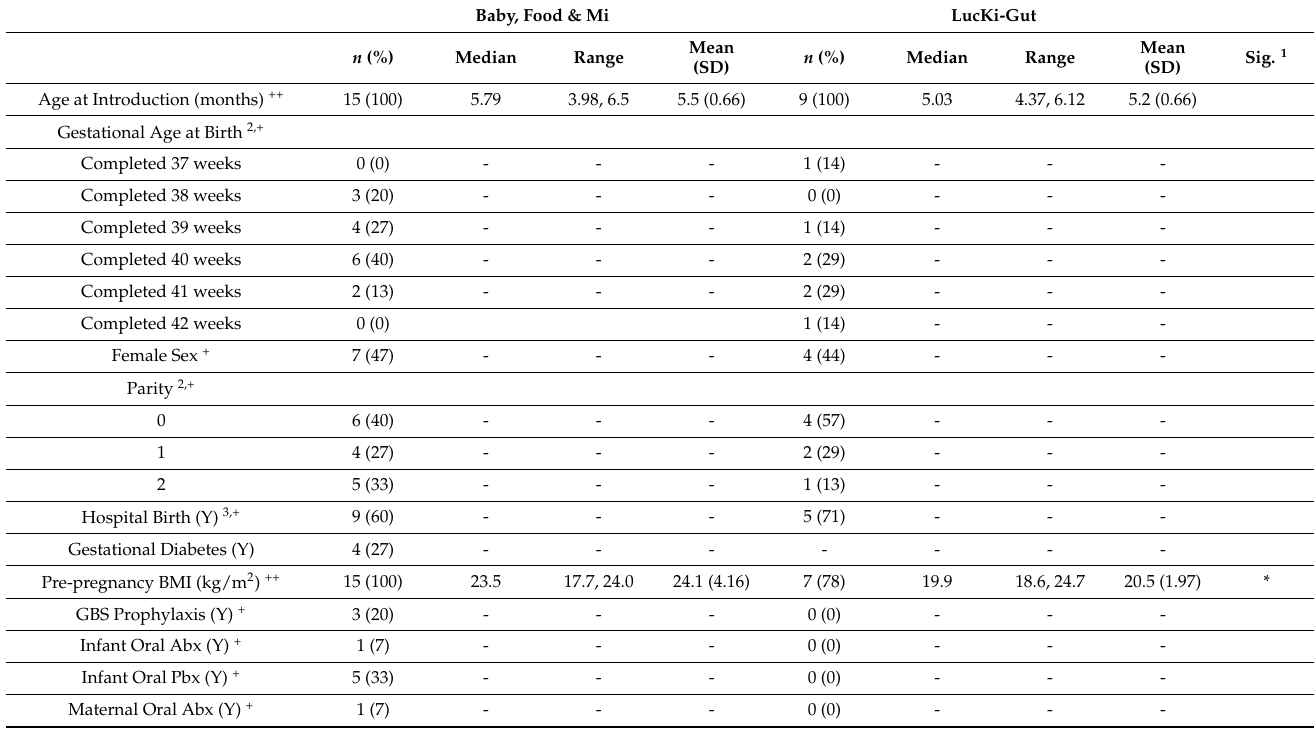
Table 1. Demographics of the study